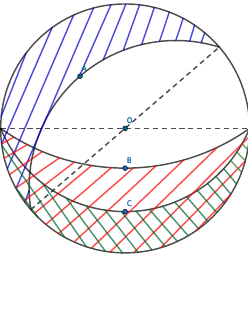
Figure 4: The “width” of the asymptoctic causal diamond is determined by how close to the equator its vertex is. A vertex at timelike infinity covers the entire Minkowski diamond, while a vertex “half-way” leads to the usual spherical Rindler wedge. The end points are determined by the anglular coordinates of the vertex and are indepen- dent of the vertex height of the ACD. They are diametrically opposite to each other, when there is no radial cut off. The curves are